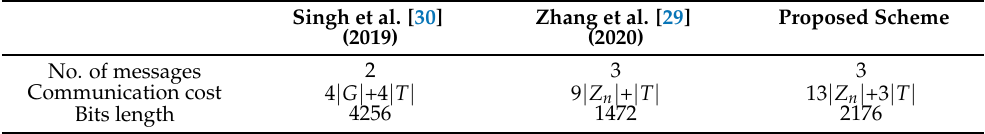
Table 4. Comparison of Communication